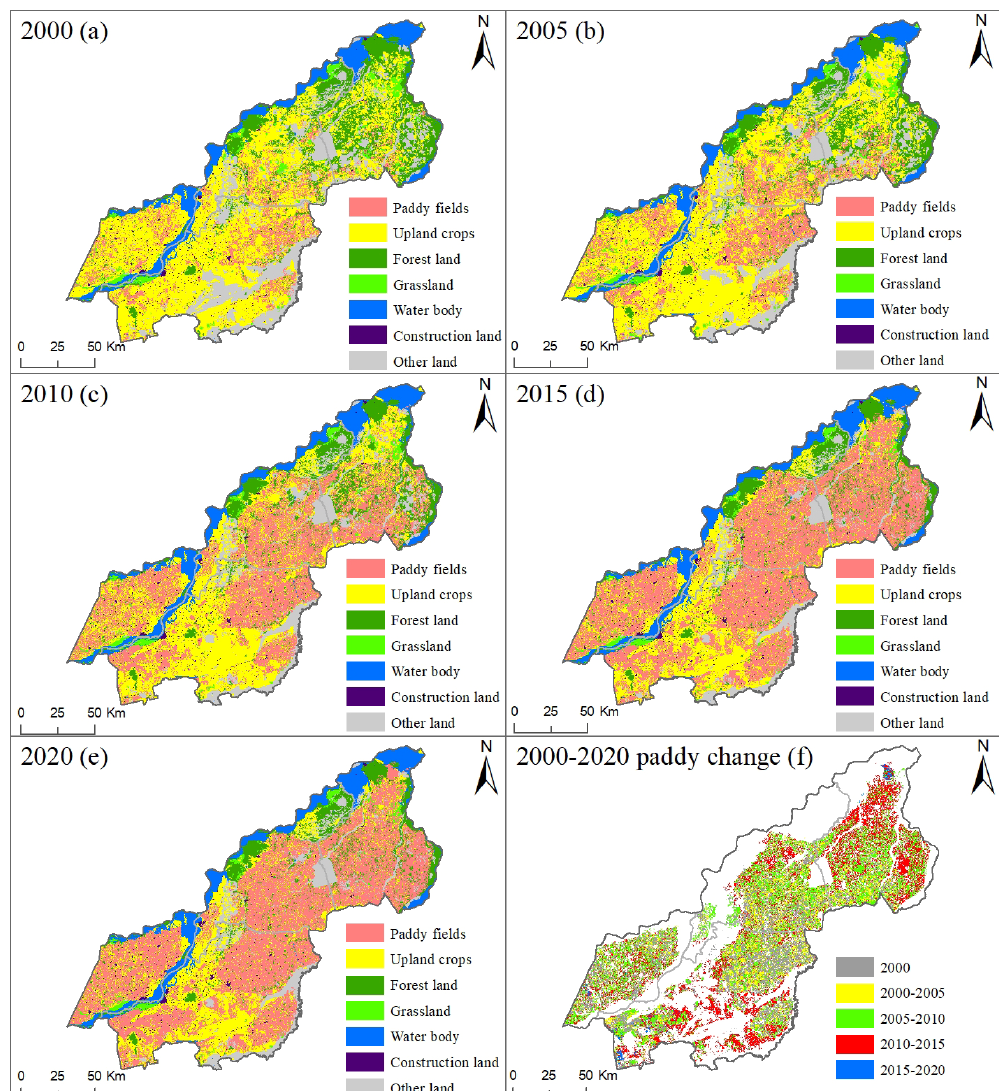
Figure 4. The spatial maps of paddy fields in the years 2000, 2005, 2010, 2015 and 2020 and their change with 5-year intervals from 2000–2020.